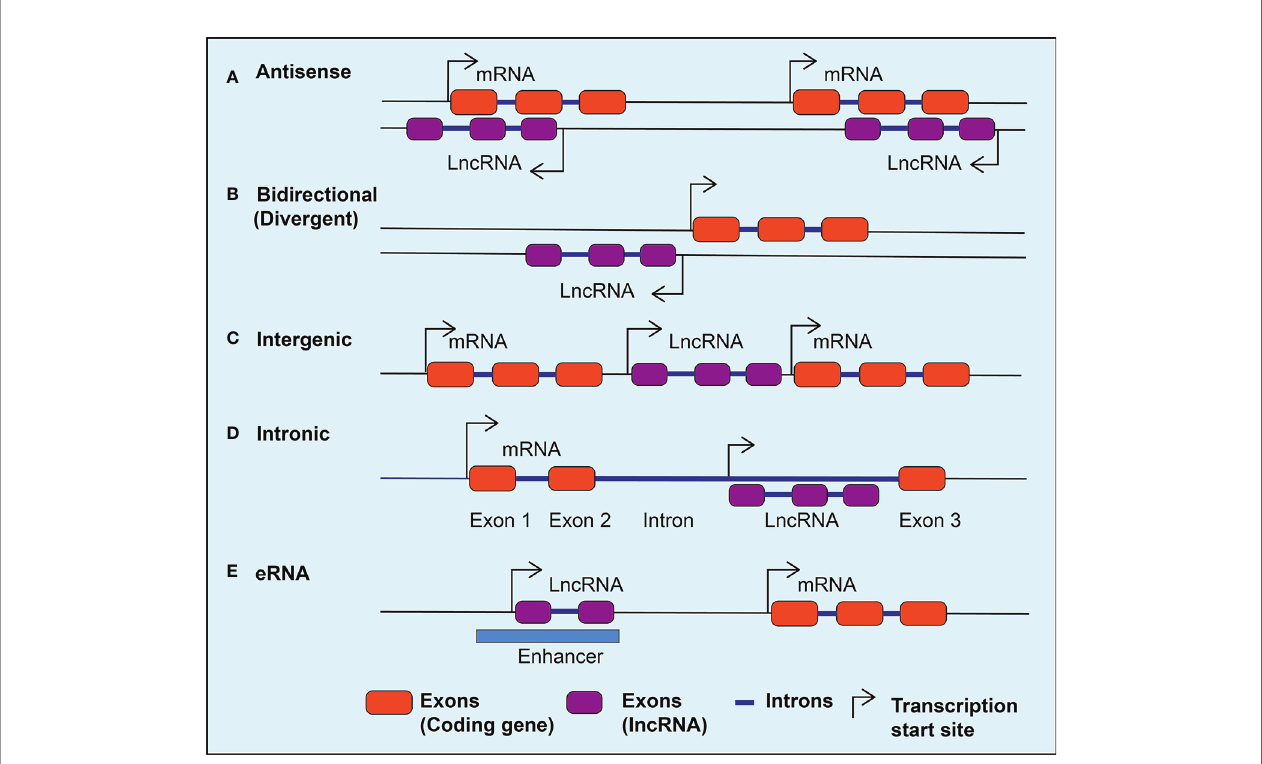
FIGURE 1 | LncRNA classi fi cation. Schematic diagram depicting different classes of lncRNAs expressed in mammalian cells. The lncRNAs can be expressed as anti-sense lncRNAs from the anti-sense strand overlapping coding genes (A) , as bidirectional or divergent transcripts from a shared promoter with coding genes (B) , as intergenic (C) , or intronic (D) , and as enhancer RNAs (eRNAs) from the enhancers (E) . Arrows indicate the direction of